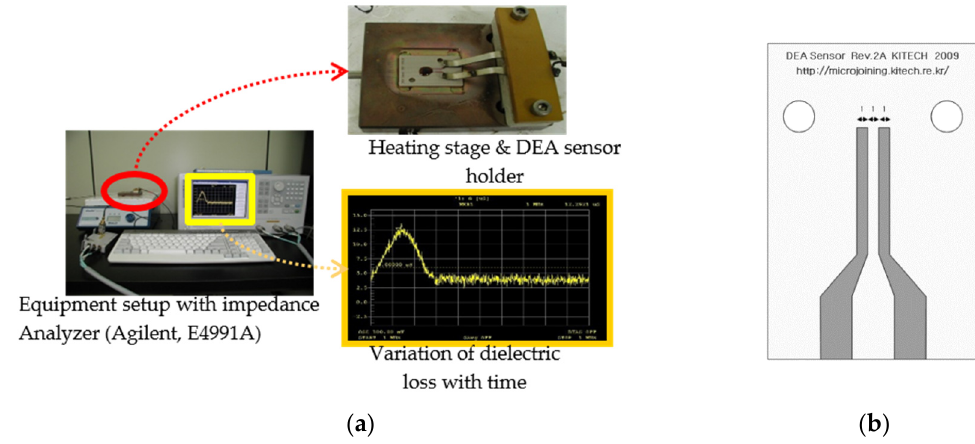
Figure 1. DEA measurement ( a ) equipment setup with impedance Analyzer, heating stage and DEA sensor, and variation of dielectric loss and ( b ) DEA sensor.